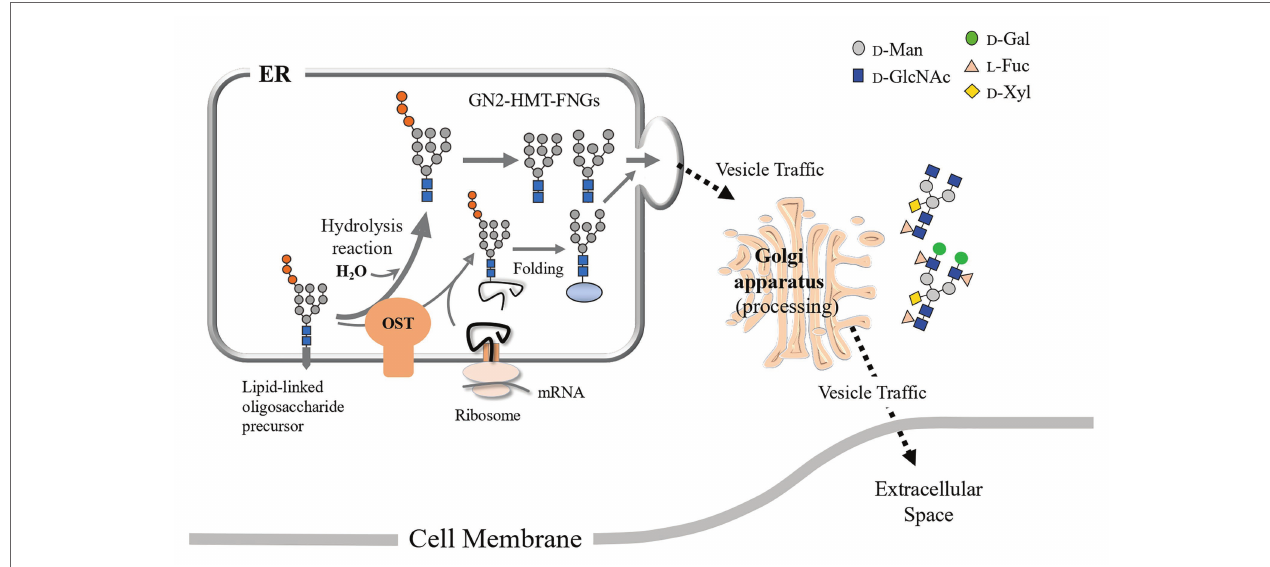
FIGURE 5 | Schematic representation of the putative processing and secretion pathway of PCT-GN2-FNGs based on the structural features of HMT-GN2-FNGs found in pumpkin microsomes is shown. These PCT-GN2-FNGs have been found in soybean seedlings (Kimura and Kitahara, 2000), a freshwater plant ( Egeria densa ; Maeda et al., 2017), and the culture broth of rice cells (Maeda et al.,